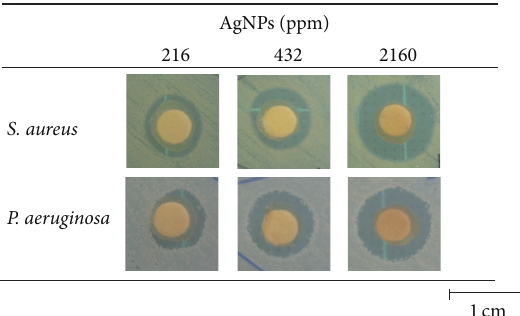
Figure 4: Disc diffusion assay shows the antibacterial properties of SF-CS-PVA films embedded with AgNPs. The inhibition of bacterial growth appears as clear zones surrounding the